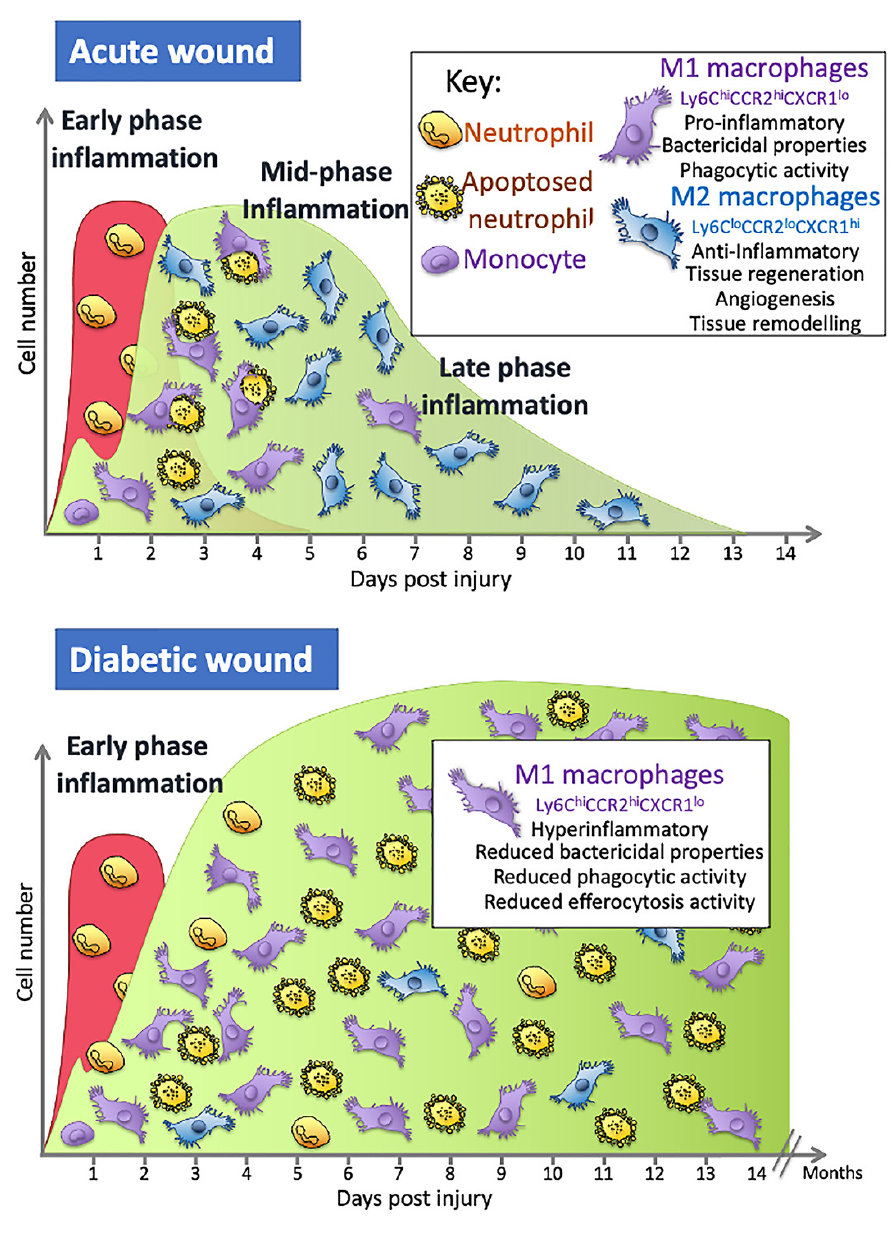
Figure 1. During the early stages of inflammation in an acute wound, the wound is predominantly populated with M1 macrophages that are pro-inflammatory. A switch in the predominant phenotype is seen later in the inflammatory phase, where the majority of macrophages are M2. In wounds of people with diabetes, macrophage numbers are altered and secrete more pro-inflammatory cytokines, have reduced phagocytic and efferocytosis abilities and are less likely to switch to the M2 phenotype in the mid- to late-inflammation phase that is as seen in normal acute wounds.